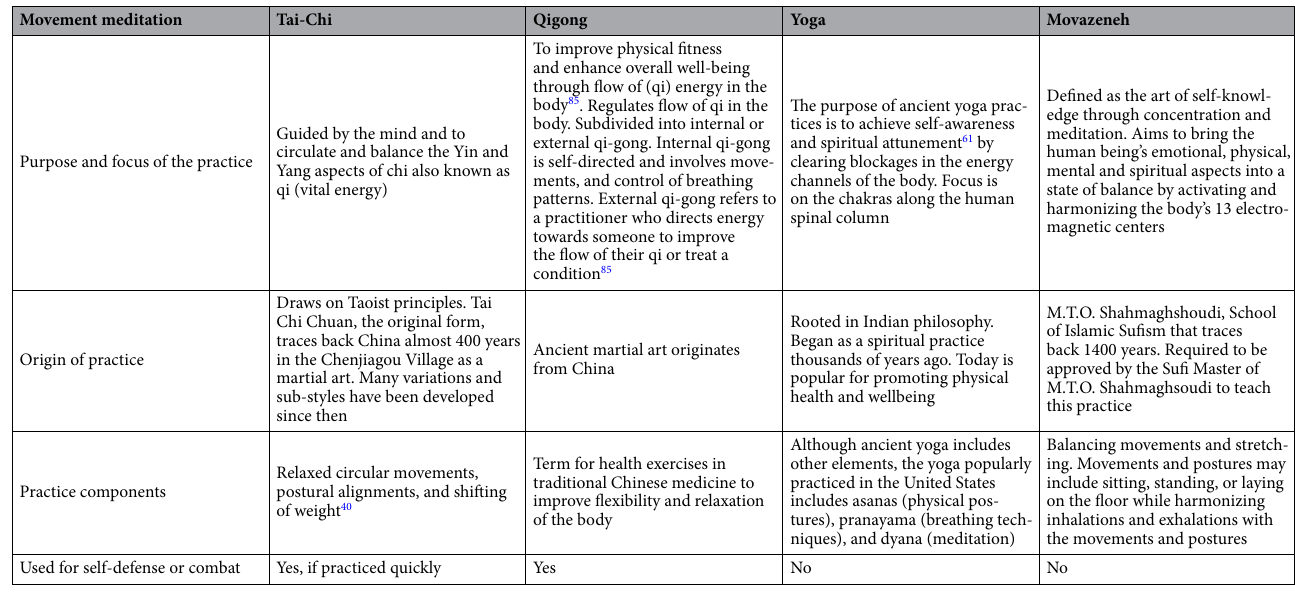
Table 2. Comparison of meditation approaches to